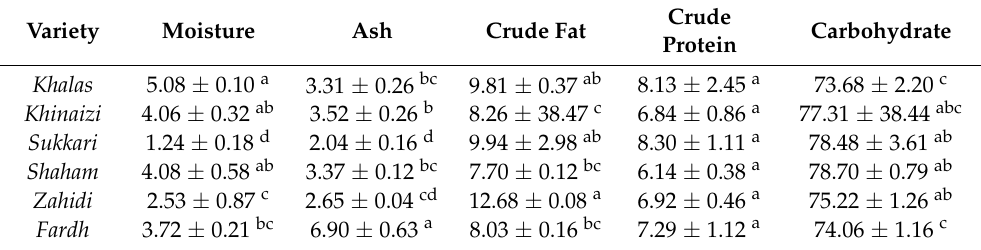
Table 1. Chemical composition of date seed powder 1 .